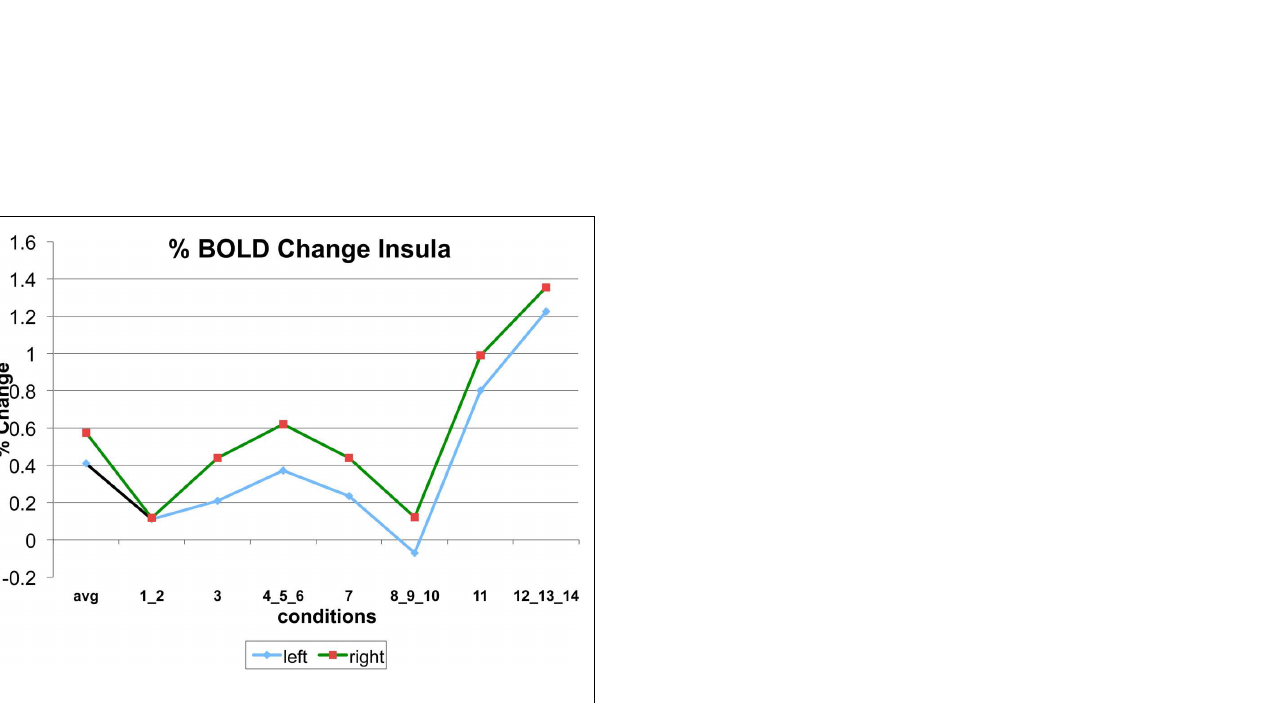
FIGUREA6 |Time series of percentage BOLD change for G(15,3).